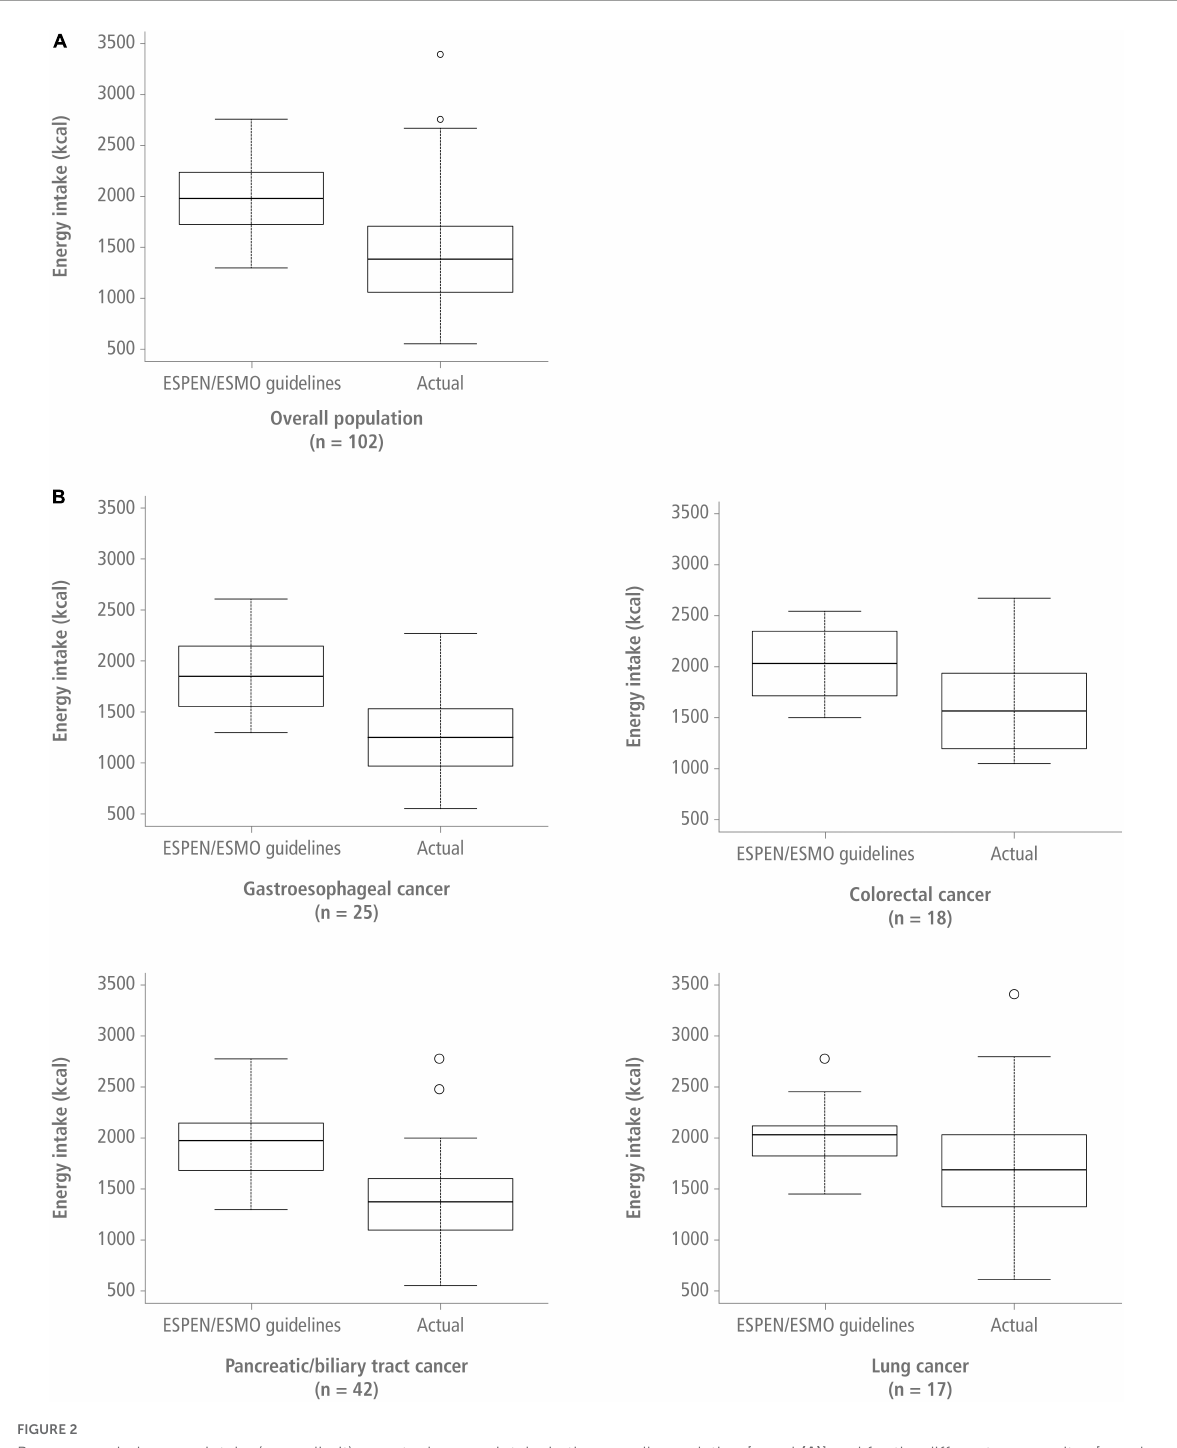
Additionally, we show good consistency between high risk for malnutrition, presence of malnutrition, and presence of cachexia, even before anticancer treatment